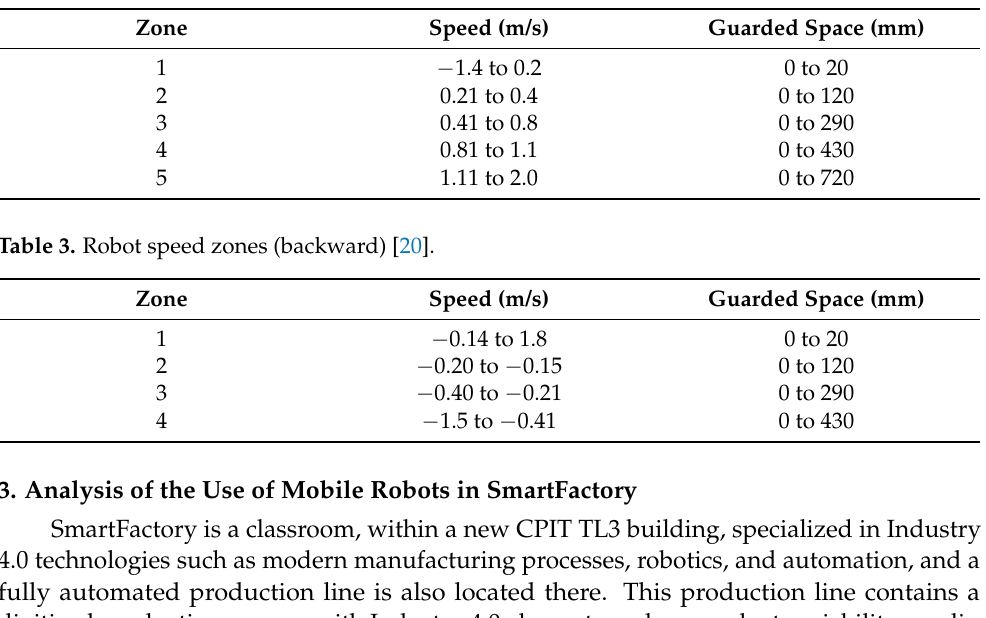
Figure 4. Mobile robot speed zones scheme [19]. Table 2. Robot speed zones (forward) [20].